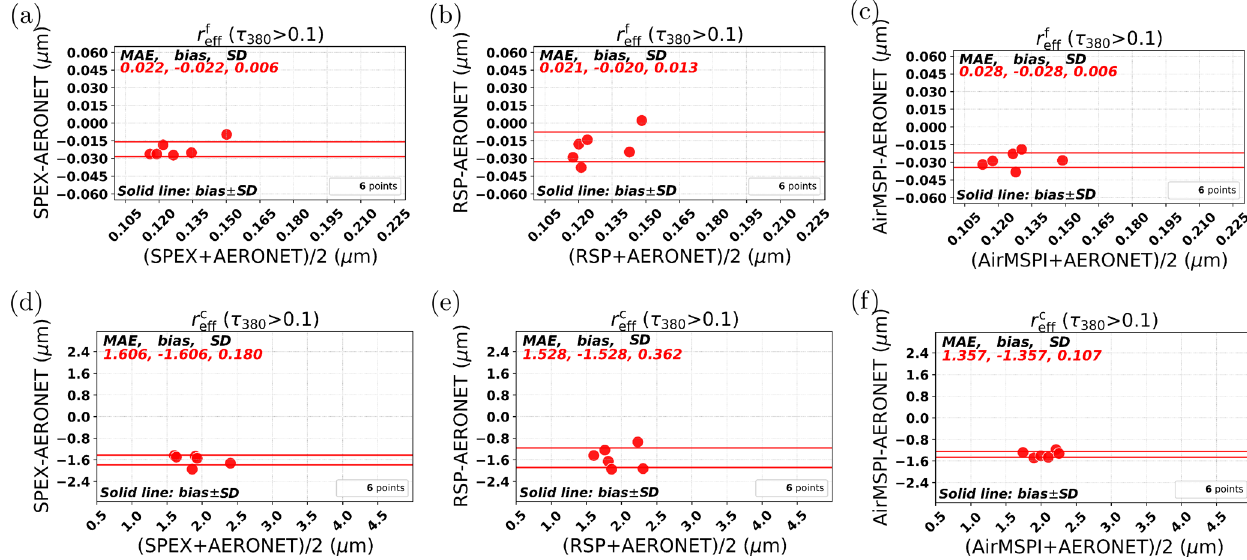
Figure 2. Comparison with AERONET for the effective radius of the fine and coarse modes ( r f retrievals. (a, b, c) Bland–Altman plots for r f AERONET, respectively. (d, e, f) Bland–Altman plots for r c AirMSPI and AERONET,